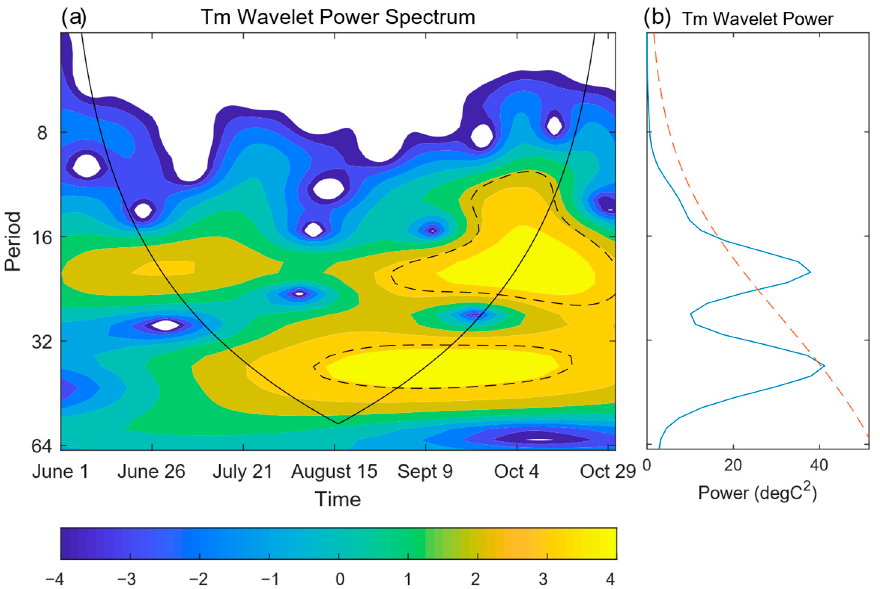
Figure 4. Wavelet analysis results of the ISO component of the T m anomaly, with wavelet spectrum ( a ) shown in the left panel and power spectrum ( b ) in the right panel. Dashed lines in both panels indicates that the results passed the 95% significant test. The black line denotes the cone of influence; everything outside it is ignored.